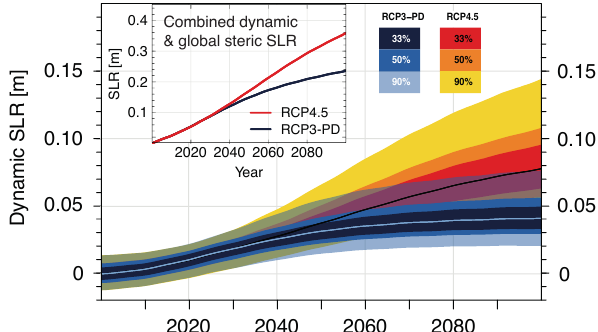
Fig. 6. Probabilistic projections of the mean dynamic sea-level rise at the New York City coastline for the RCP3-PD (blue) and the RCP4.5 (orange) emission pathway until 2100. We project a me- dian dynamic sea-level rise of 4 cm for the RCP3-PD and 8 cm for the RCP4.5 scenario. Inlay: Estimates of the steric and dynamic sea-level rise at the New York City coastline by combining our projections with simulations of the global steric sea-level rise by Schewe et al. (2011).